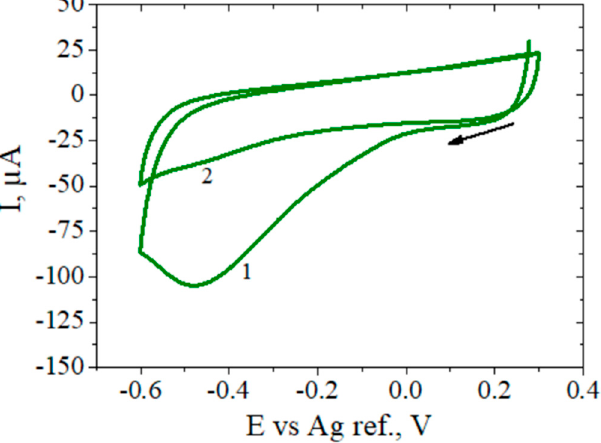
Figure 4. CVs corresponding to the 1st and 2nd cycles of the reduction of 4–carboxyphenyl diazonium salt (generated in situ) at the RGO/SPCE (potential sweep from +0.3 V to –0.6 V at 0.1 V/s).